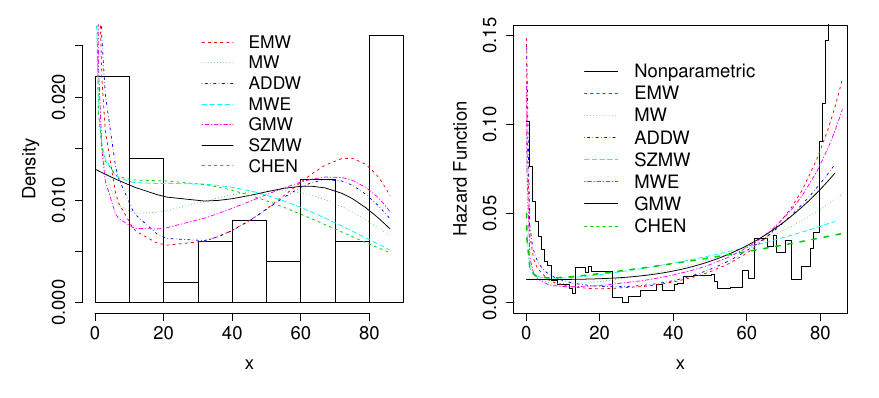
(a) The plots of density function. (b) The plots of hazard rate function.